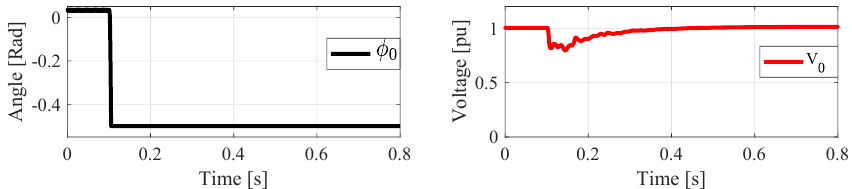
Figure 8. Reference voltage angle ( left ) and voltage magnitude ( right ) generated by the proposed controller for